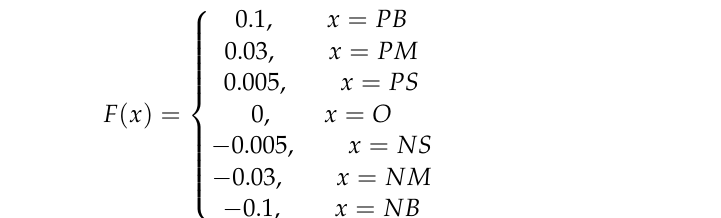
Table 2. Fuzzy-control rule table for C w trimming.